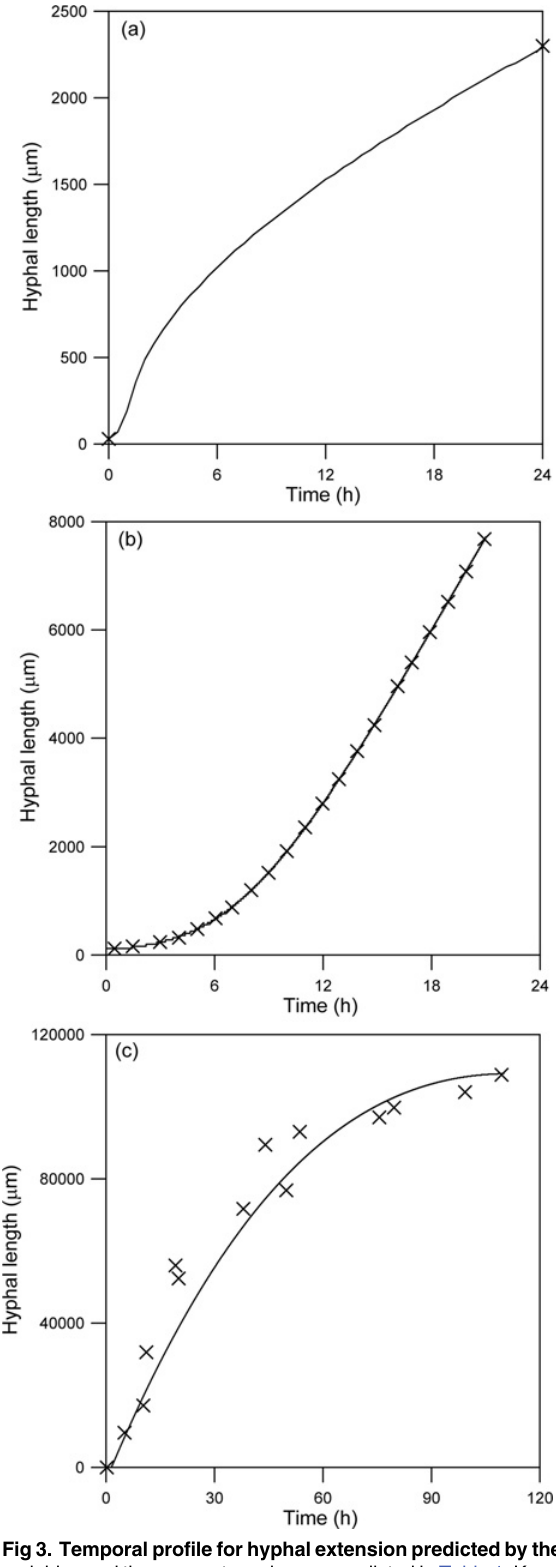
Fig 3. Temporal profile for hyphal extension predicted by the calibrated model. The initial values of the variables and the parameter values are as listed in Table 1. Key: ( — ) Model predictions; (×)